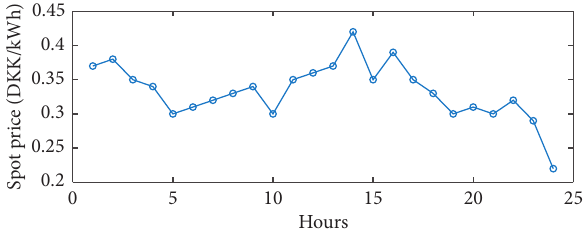
Figure 2: Forecasted spot prices.